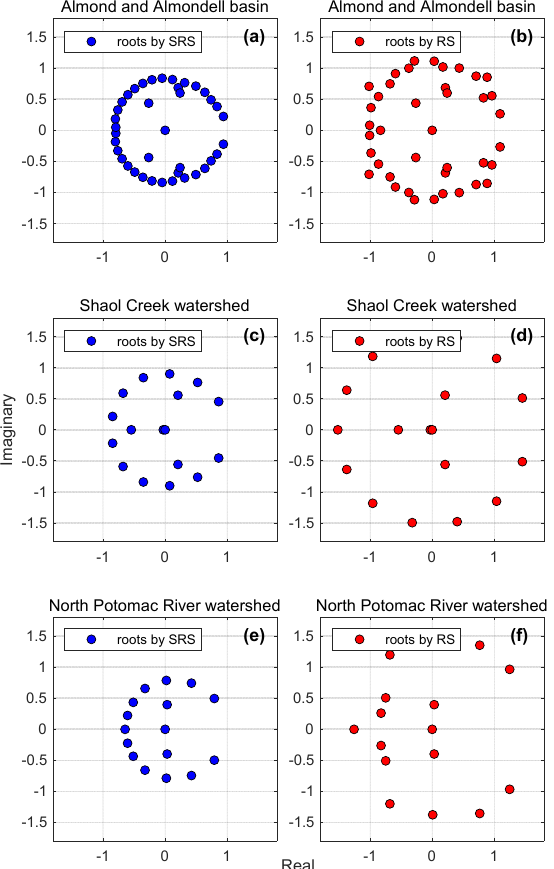
Figure 6. Comparison between Argand diagrams of the storms for different three basins obtained by the SRS method (left panel of each row) and the RS method (right panel of each row): ( a , b ) for Almond and Almondell basin; ( c , d ) for Shaol Creek watershed; ( e , f ) for North Potomac River watershed.